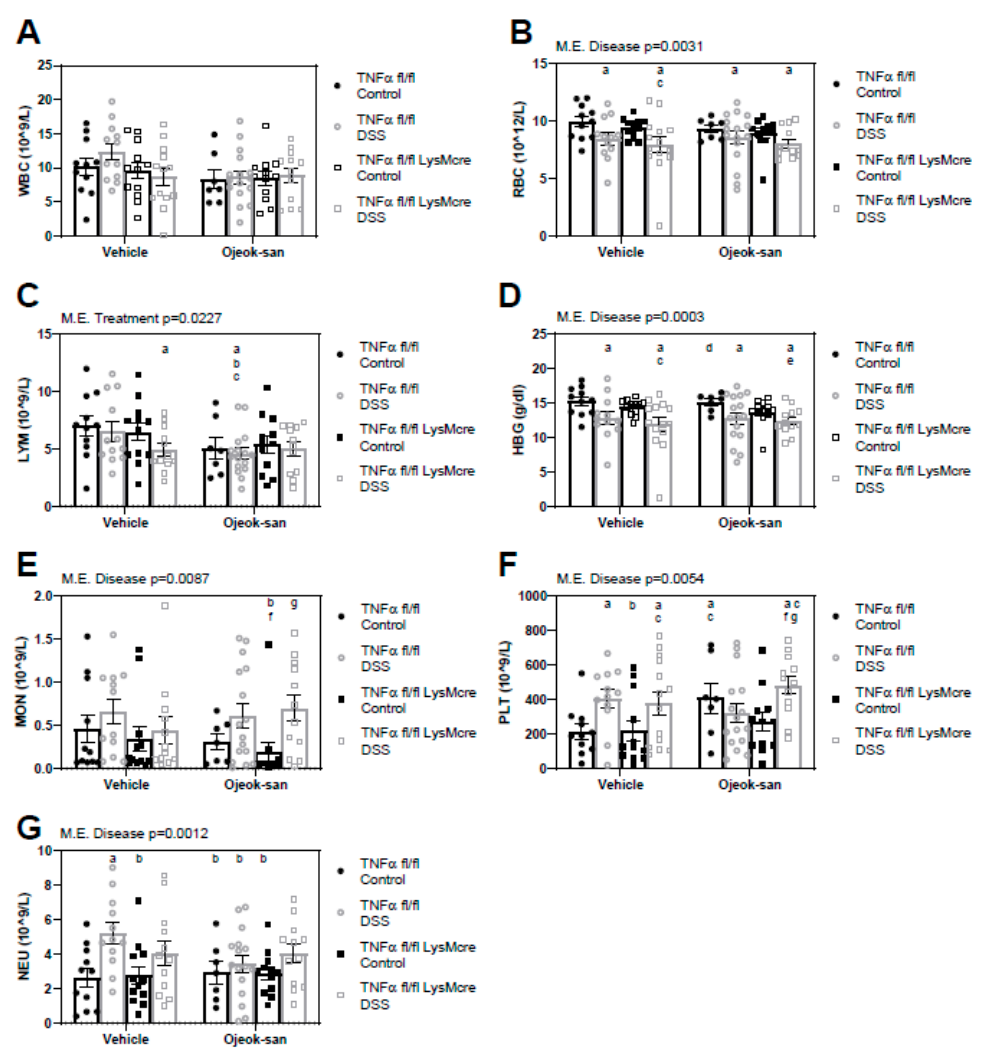
Figure 4. Macrophage deletion of TNF α does not impact blood profile, but Ojeok-san administration diminishes lymphocyte levels in mice with colitis. ( A ) WBC, ( B ) RBC, ( C ) LYM, ( D ) HGB, ( E ) MON, ( F ) PLT, ( G ) NEU following acute DSS administration and OJS treatment in TNF α fl / fl and TNF α fl / fl -LysMCre mice. Values are represented as mean ± SEM; n = 7–18 mice per group. Three-way ANOVA followed by uncorrected Fisher’s LSD post hoc test. Letters indicate statistical significance ( p < 0.05) from a TNF α fl / fl Control-Vehicle, b TNF α fl / fl DSS-Vehicle, c TNF α fl / fl LysMcre Control- Vehicle, d TNF α fl / fl LysMcre DSS-Vehicle, e TNF α fl / fl Control-OJS, f TNF α fl / fl DSS-OJS, g TNF α fl / fl LysMcre Control-OJS.